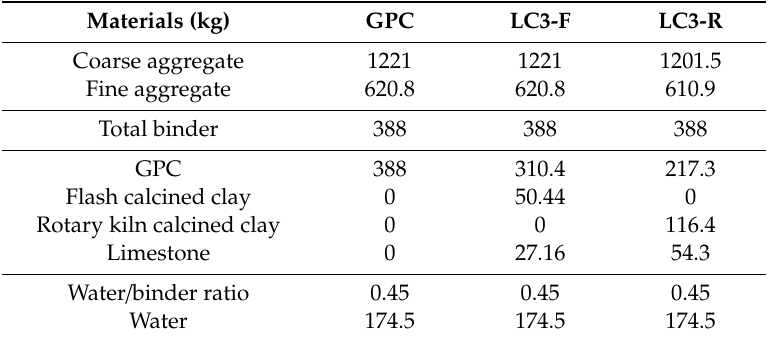
Table 2. Mix compositions. GPC: general purpose cement; LC3-F: limestone calcined clay cement